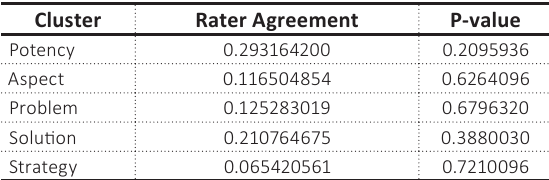
Table 3. P-value of the rater